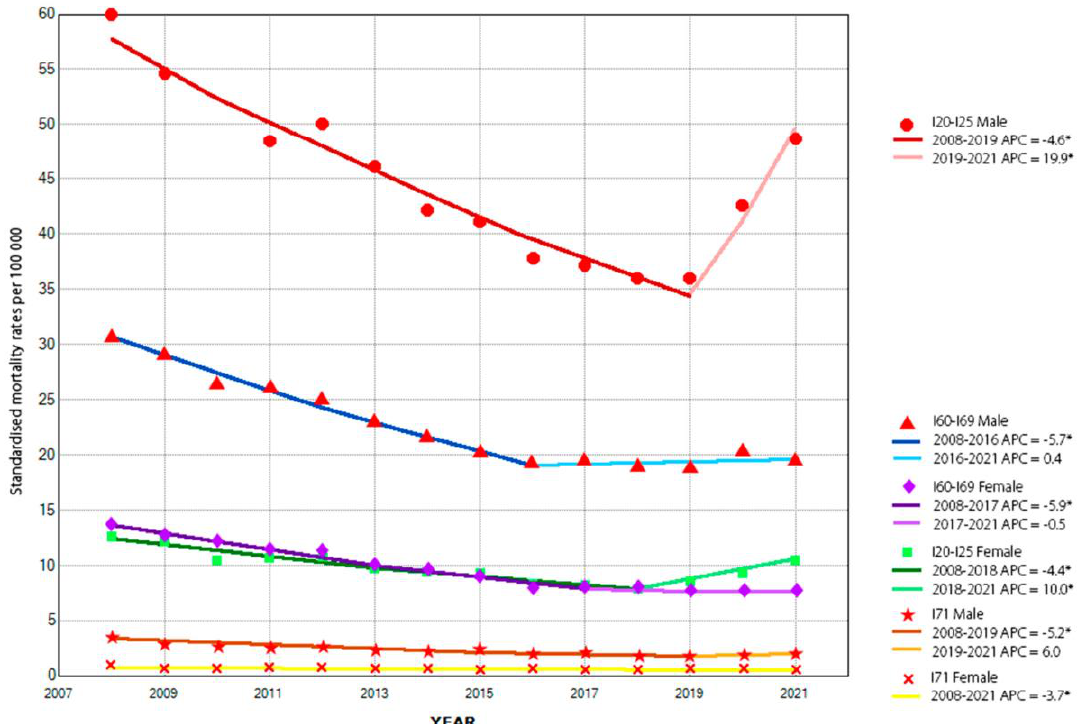
Figure 1. Time trends of standardized mortality rates due to the analyzed groups of cardiovascular diseases. contain information on annual percentage change (APC) of standardized mortality rates due to analyzed groups of cardiovascular diseases. * the significant values were marked at p < 0.05. Table 3. Time trends of standardized mortality rates due to the analyzed groups of cardiovascular diseases.